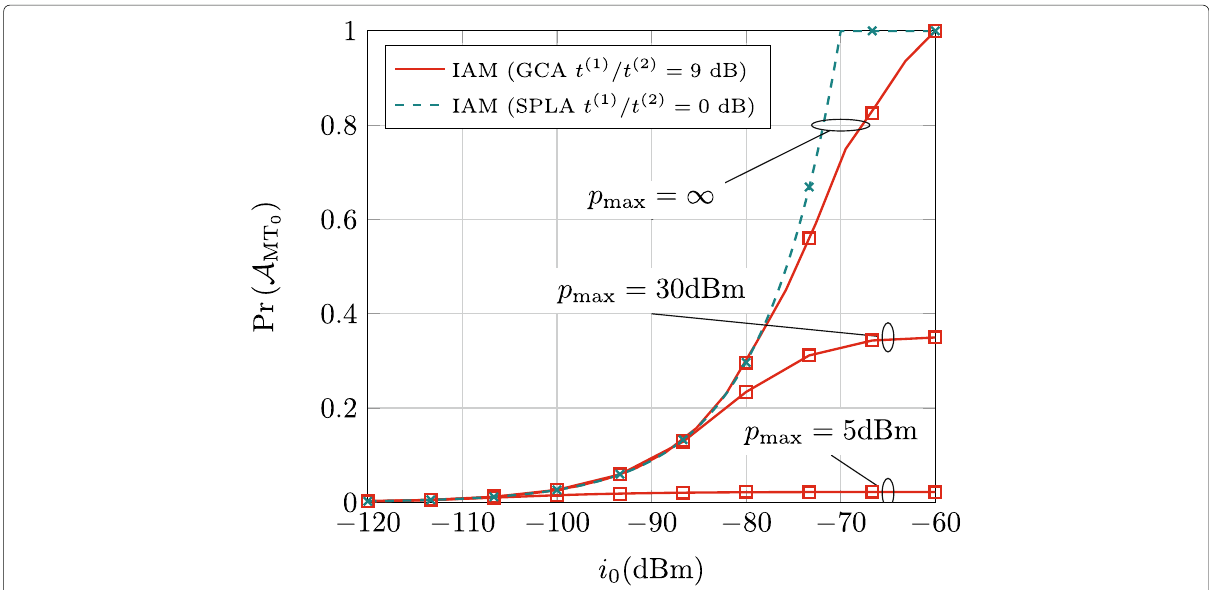
Fig. 2 Probability of being active of the typical MT for IAM with (cid:5) = 1, p max → ∞ , p max = 30 dBm, and p max = 5